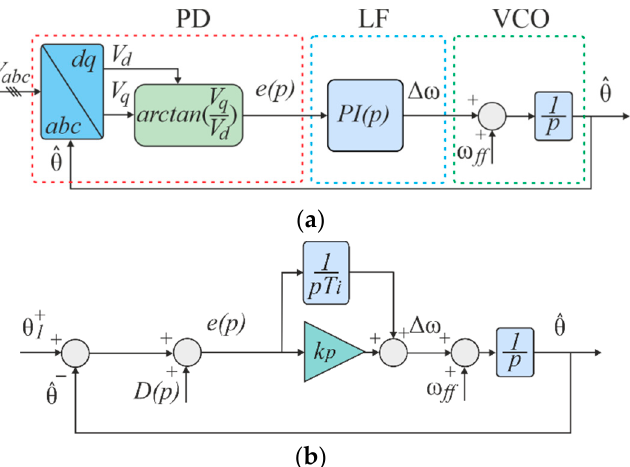
Figure 1. Synchronous reference frame phase-locked loop (PLL). ( a ) Block diagram; ( b ) small-signal model.